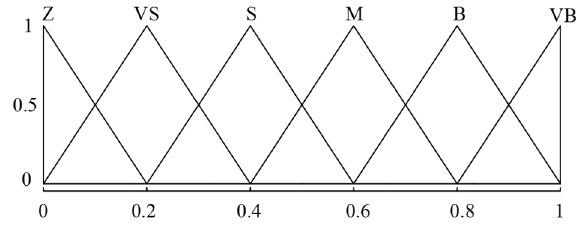
Figure 10. Membership functions of the outputs.